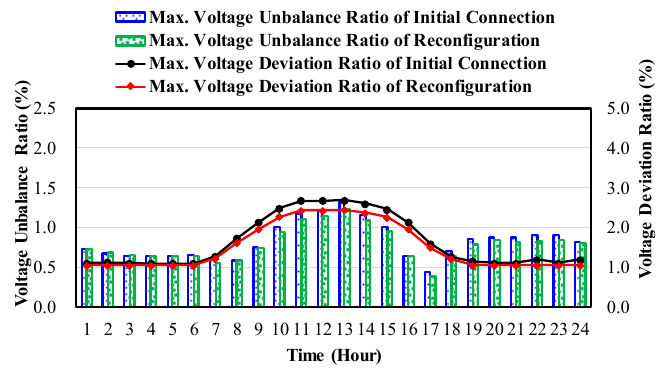
Figure 11. Daily voltage profile.